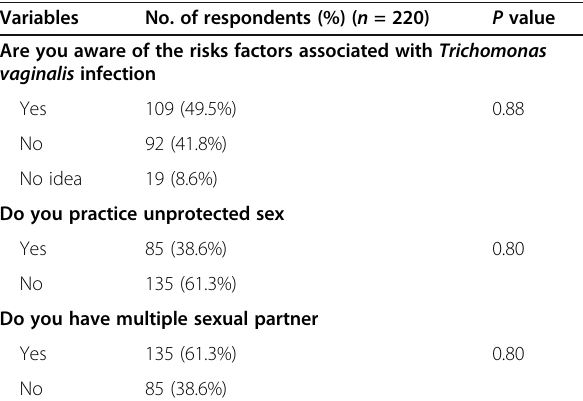
Table 4 Risk factors of Trichomonas vaginalis and HIV infection among the inmates in Umuahia Prisons, Abia State